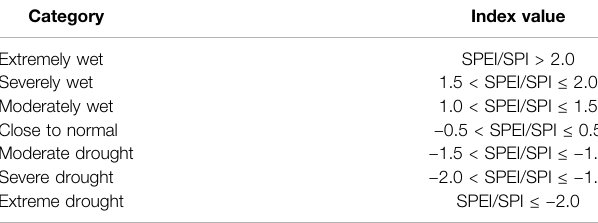
TABLE 1 | SPI and SPEI classi fi cation and categories 1